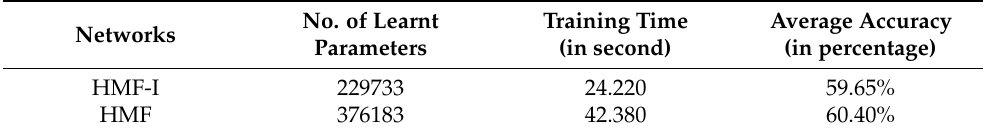
Figure 7. Comparison of the proposed HMF-I and HMF in ( a ) classification accuracy and ( b ) training curves.